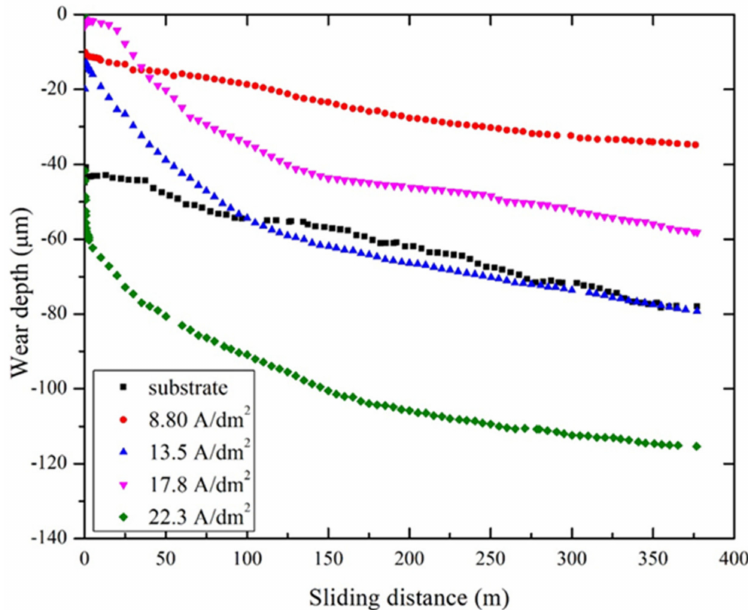
Figure 5. Wear depths measured on both the substrate and PEO-coated Al 7075 samples. PEO-coated samples formed under different current densities of ( • ) 8.8 A/dm 2 , ( (cid:78) ) 13.5 A/dm 2 , ( (cid:72) ) 17.8 A/dm 2 , and ( (cid:7) ) 22.3 A/dm 2